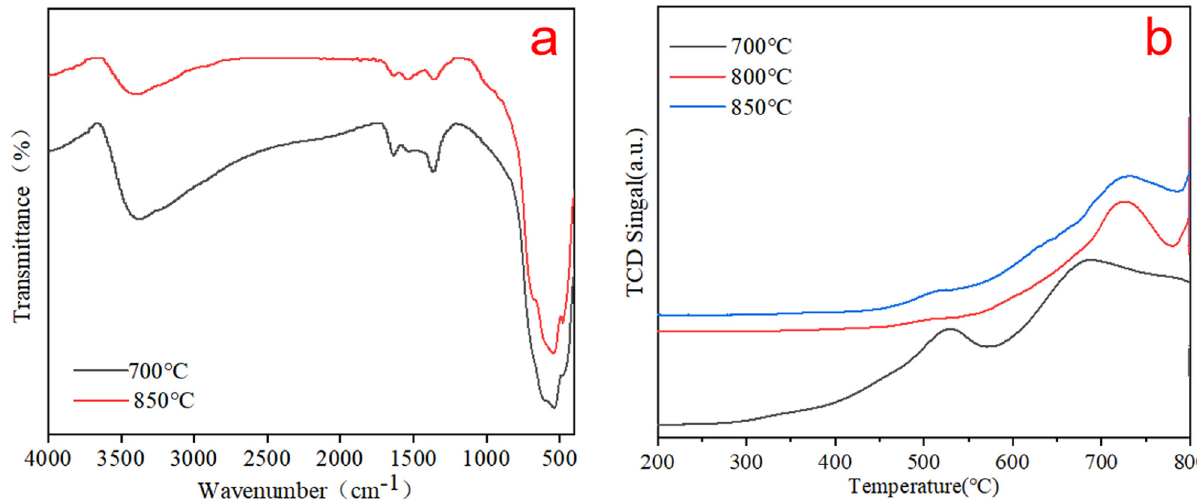
Figure 4: FTIR spectra ( a ) and H 2 - TPR diagram ( b ) of the Fe – Sn – O catalyst prepared at di ff erent calcination temperatures.